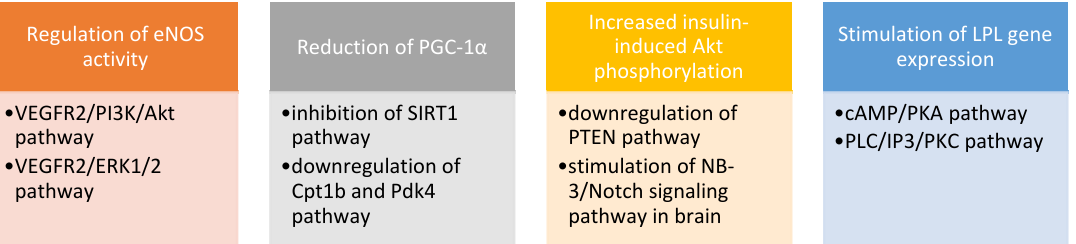
Figure 4. Adropin-triggered intracellular signal transduction pathways. eNOS—endothelial nitric oxide synthase; VEGFR2—vascular endothelial growth factor receptor 2; PI3K—phosphatidylinositol 3-kinase; Akt—protein kinase B; ERK1/2—extracellular signal-regulated kinase 1 / 2 ; PGC-1 α — peroxisome proliferators-activated receptor- γ coactivator-1 α ; SIRT1—silent information